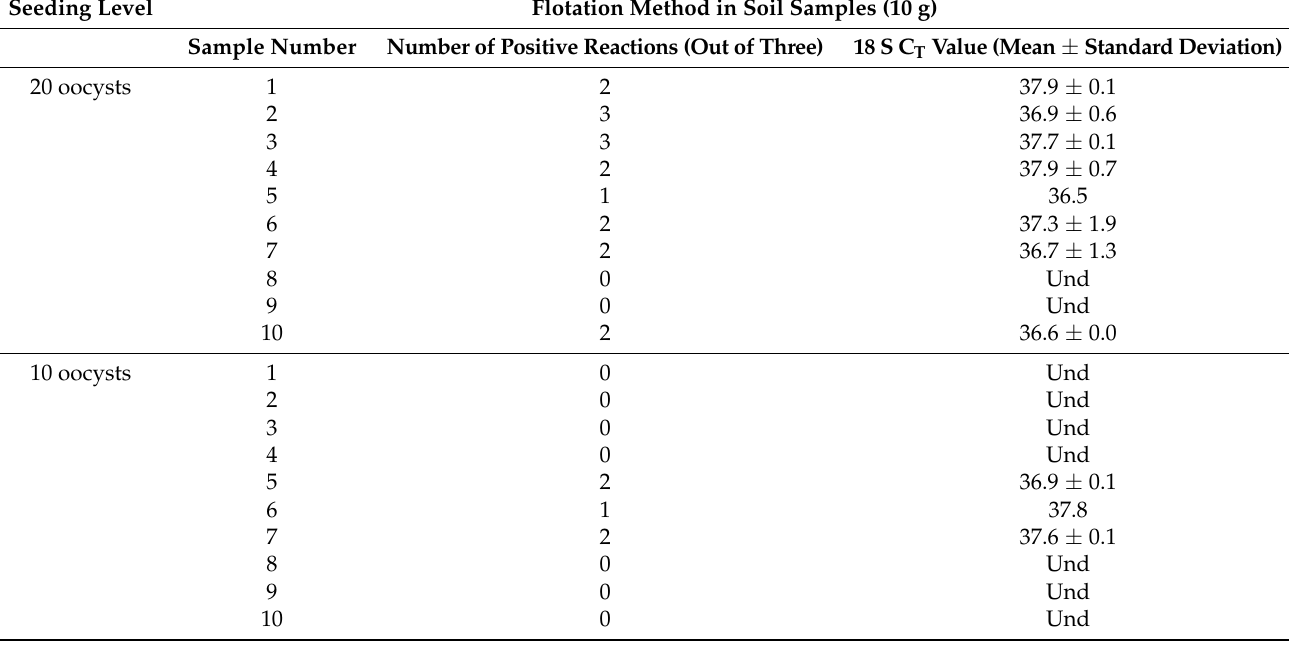
Table 3. qPCR detection data (number of positive qPCR replicates, individual C T values) for C. cayetanensis detection in samples of soil (10 g) seeded with 20 and 10 C. cayetanensis oocysts using the flotation in dense sucrose solution method and molecular detection of the parasite.